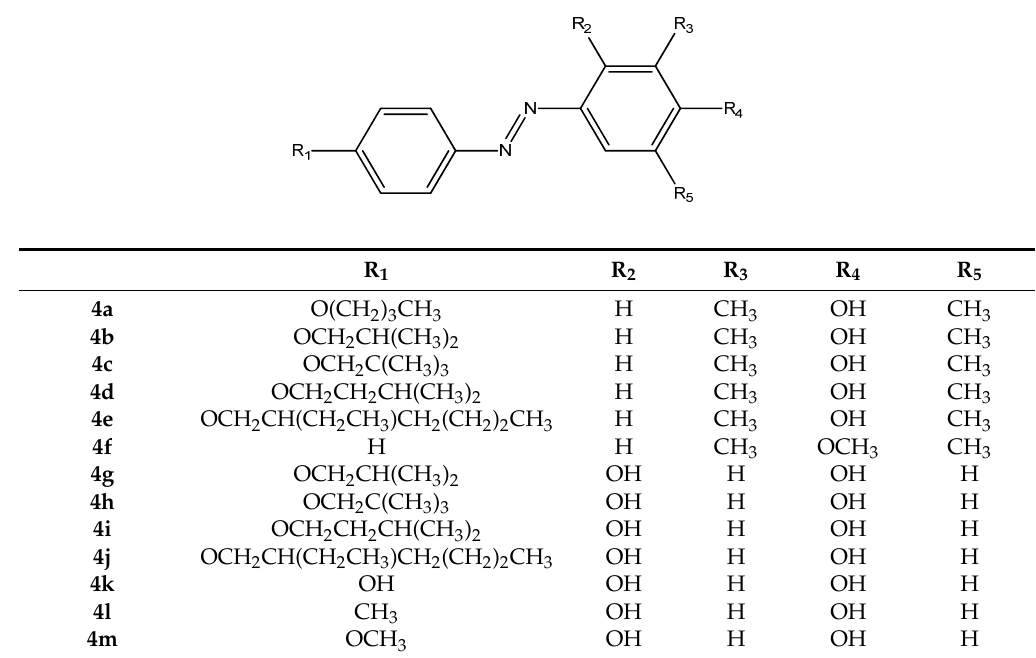
Figure 2. Substituted-(phenyl-diazenyl) phenols derivatives ( 4a – m ).